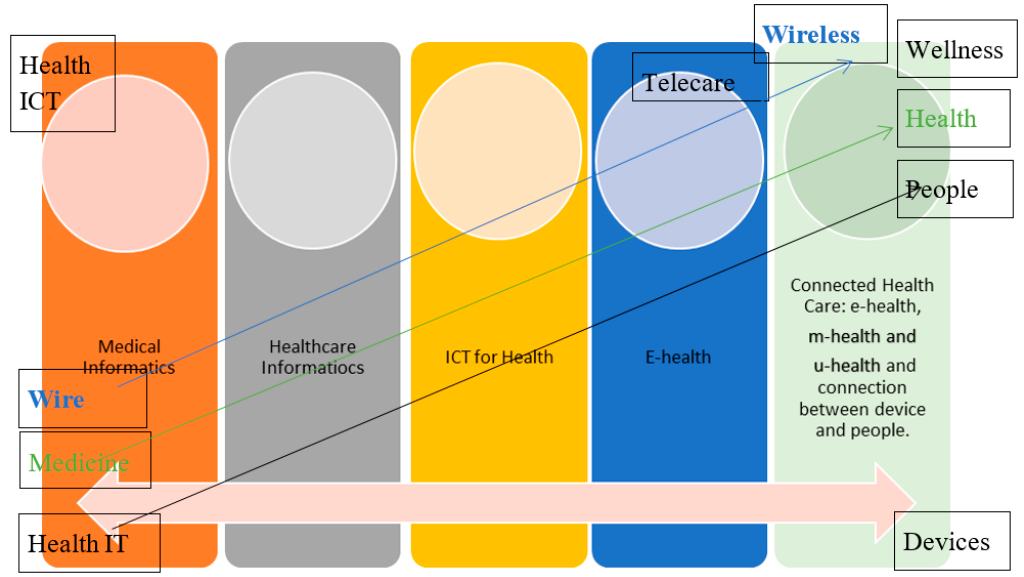
Figure 5. The development of Information and Communications Technology (ICT) in health.